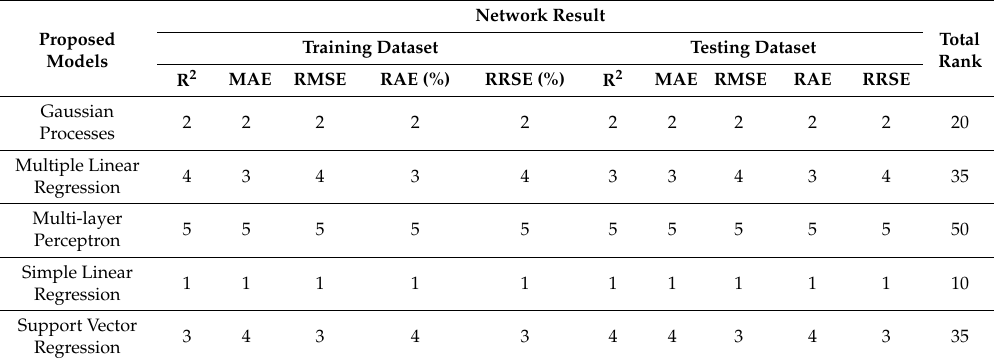
Table 3. Total ranking of both training and testing dataset in predicting the factor of safety. Proposed